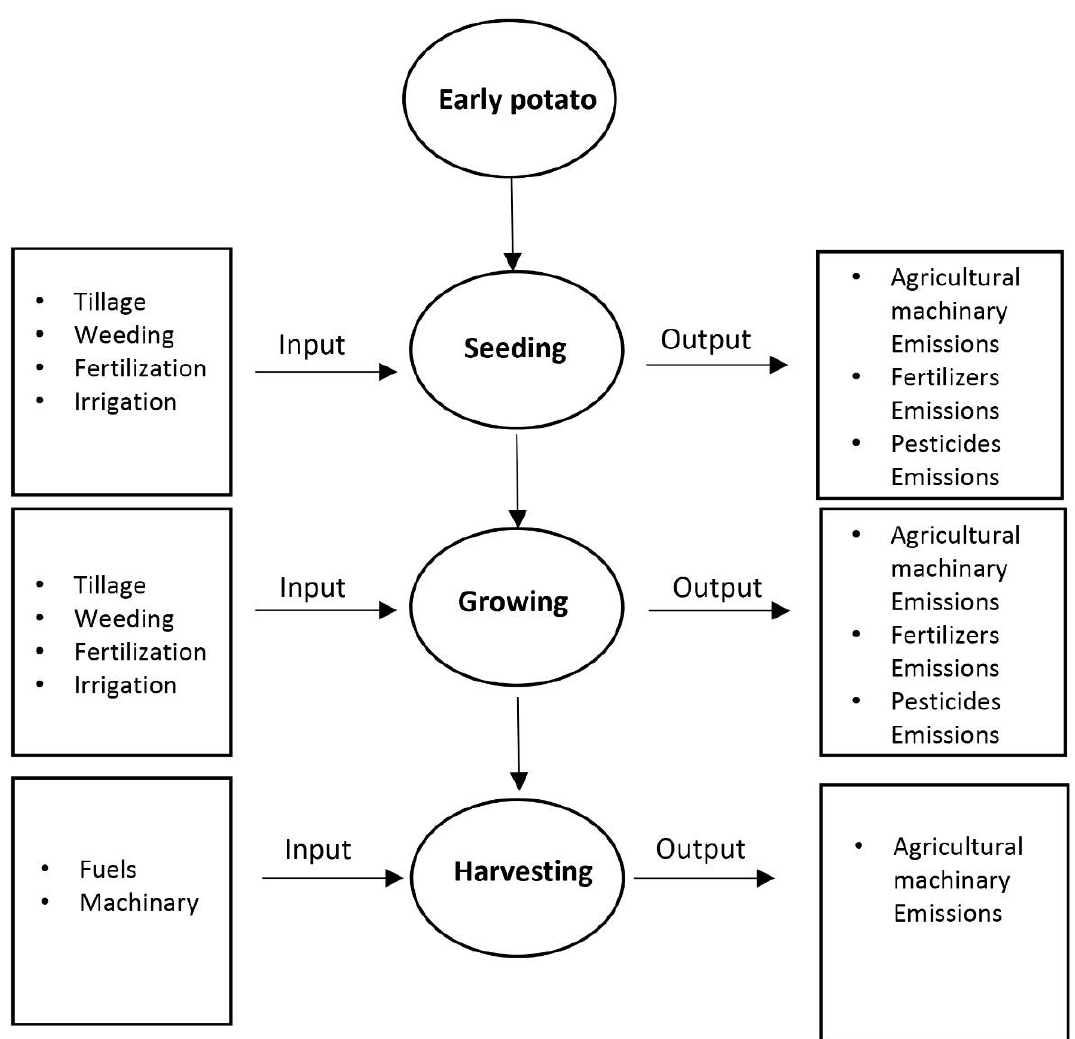
Figure 1. System boundary in the evaluation of LCA in early potatoes .